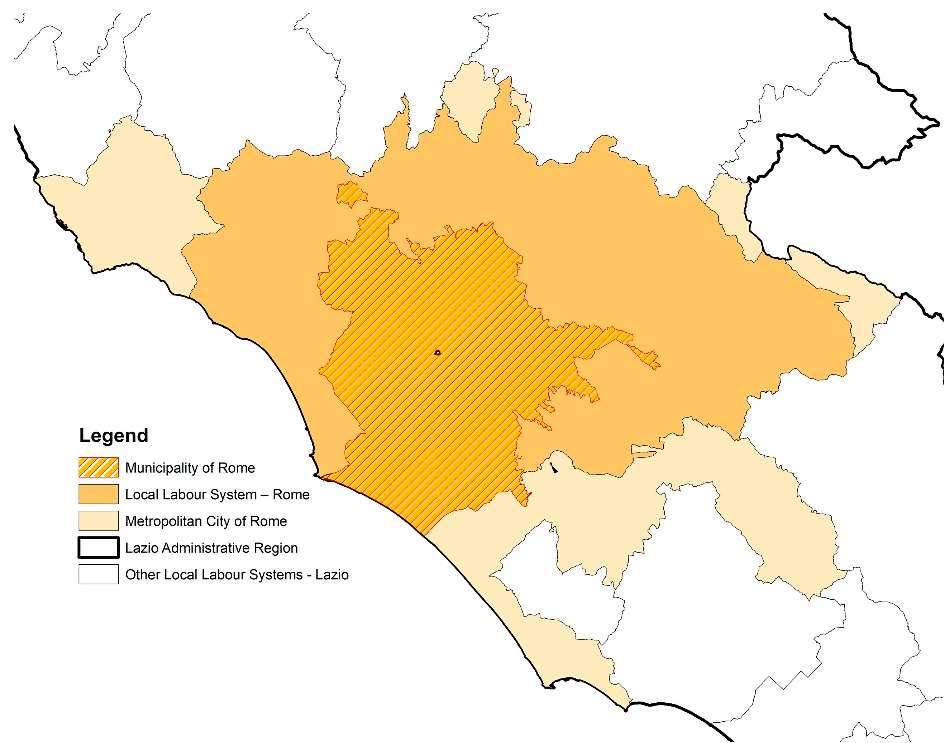
Figure 1. Administrative borders and Rome’s Local Labor System. Source: https://www.istat.it.